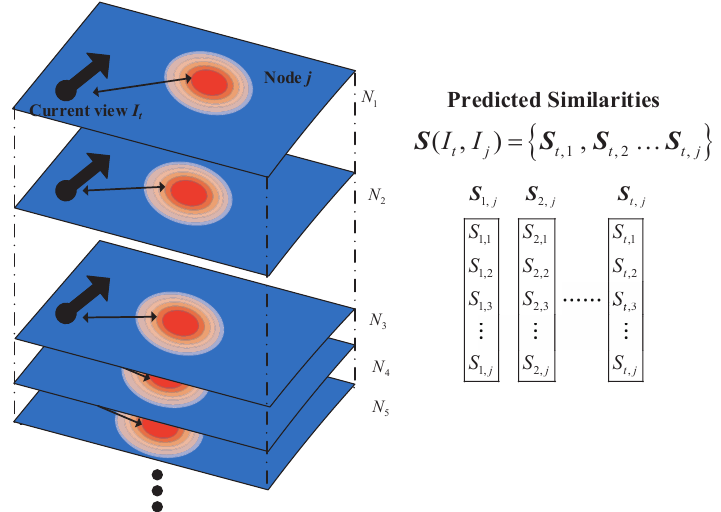
Figure 5. The definition of the similarity between the current view and topological